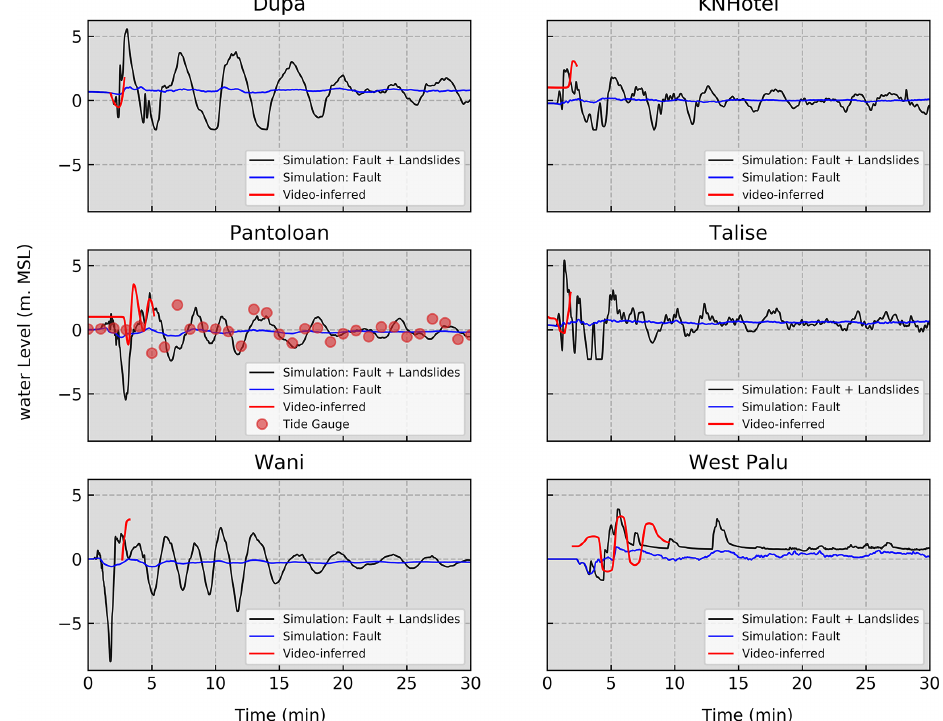
Figure 11. Time series of sea level for the 2018 Palu tsunami at six locations: Dupa, the KN Hotel, Pantoloan, Talise, Wani, and West Palu. The black line represents the simulated waveform based on submarine landslides and seismic faults, the blue line represents the simulated waveform based on seismic fault, and the red line represents the video-inferred waveform retrieved from Carvajal et al. (2019). The simulated and observed waveforms are de-tided and adjusted to the same model’s terrain datum. The location of each CCTV system is shown in Fig.